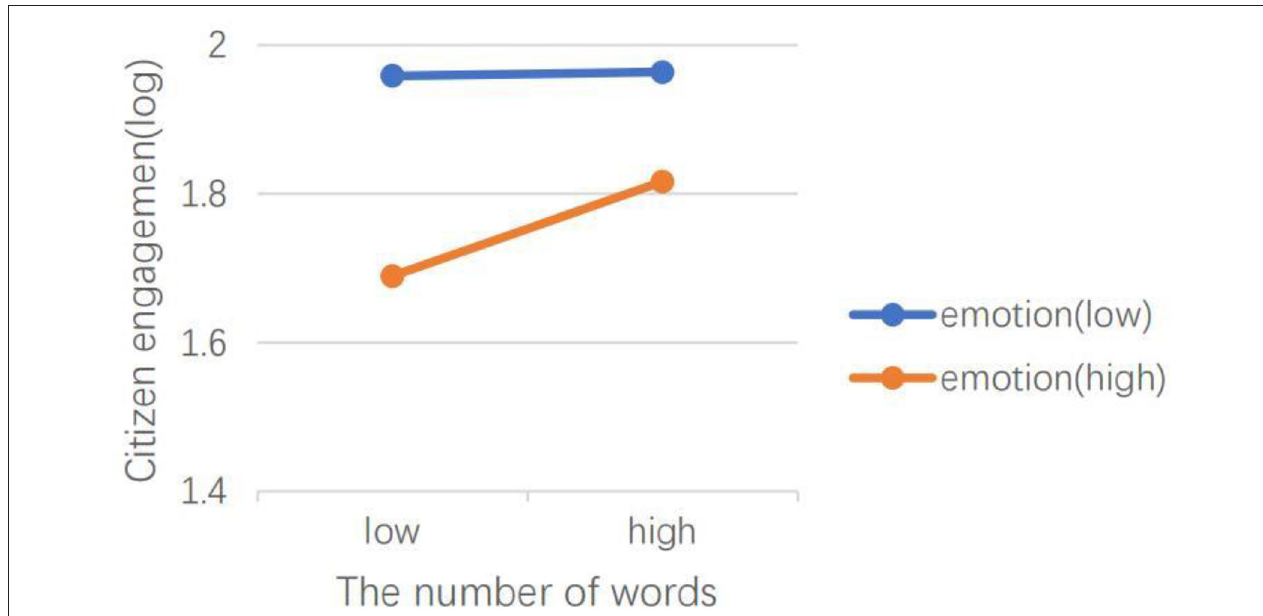
FIGURE 5 | Two-way interaction between the number of words contained in posts and emotional valence in predicting CEGSM in the initial containment stage.